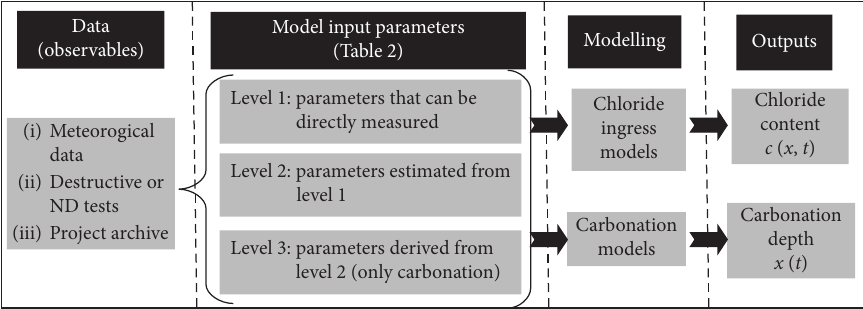
Figure 2: General representation of input parameters for analytical carbonation and chloride ingress models by Rakotovao Ravahatra et al. [17]. Table 2: Classification and data required for determining model input